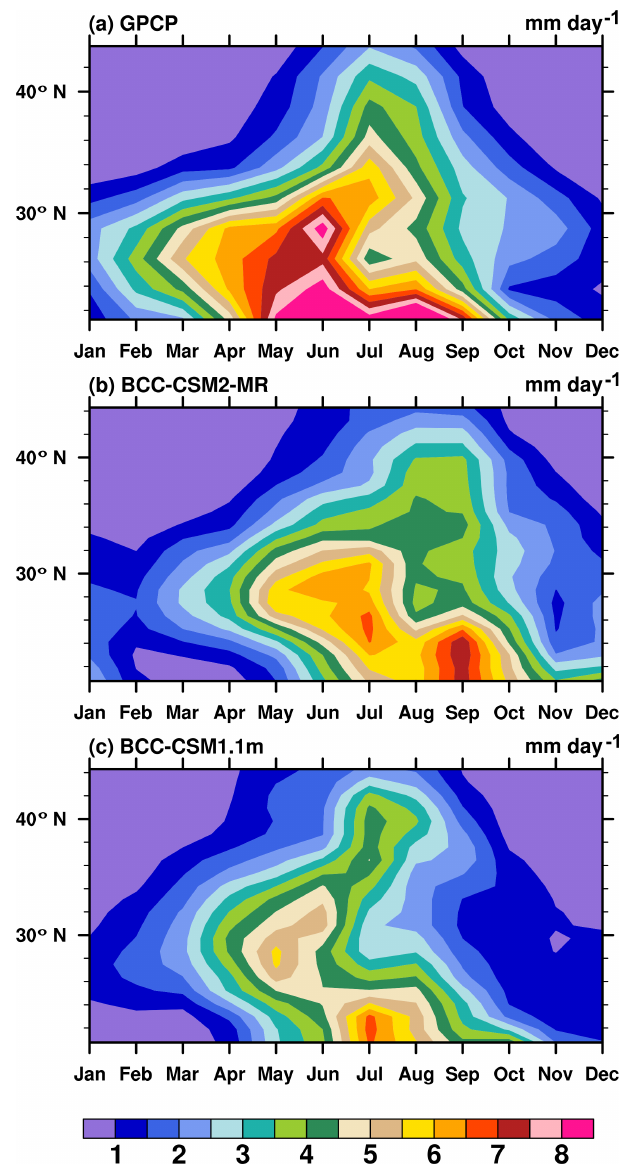
Figure 19. Latitude (from 20 to 25 ◦ N) – month (January to De- cember) diagrams showing variations of monthly precipitation av- eraged over 100–120 ◦ E and for the 1980–2005 period. (a) GPCP, (b) BCC-CSM2-MR, and (c) BCC-CSM1.1m. (Units: mmd − 1